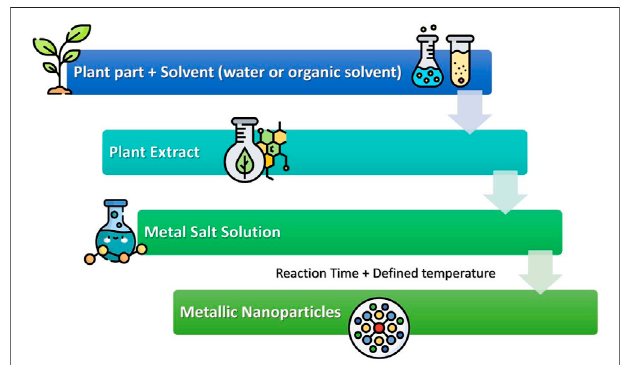
FIGURE 1 | Schematic simple way to produce plant-based